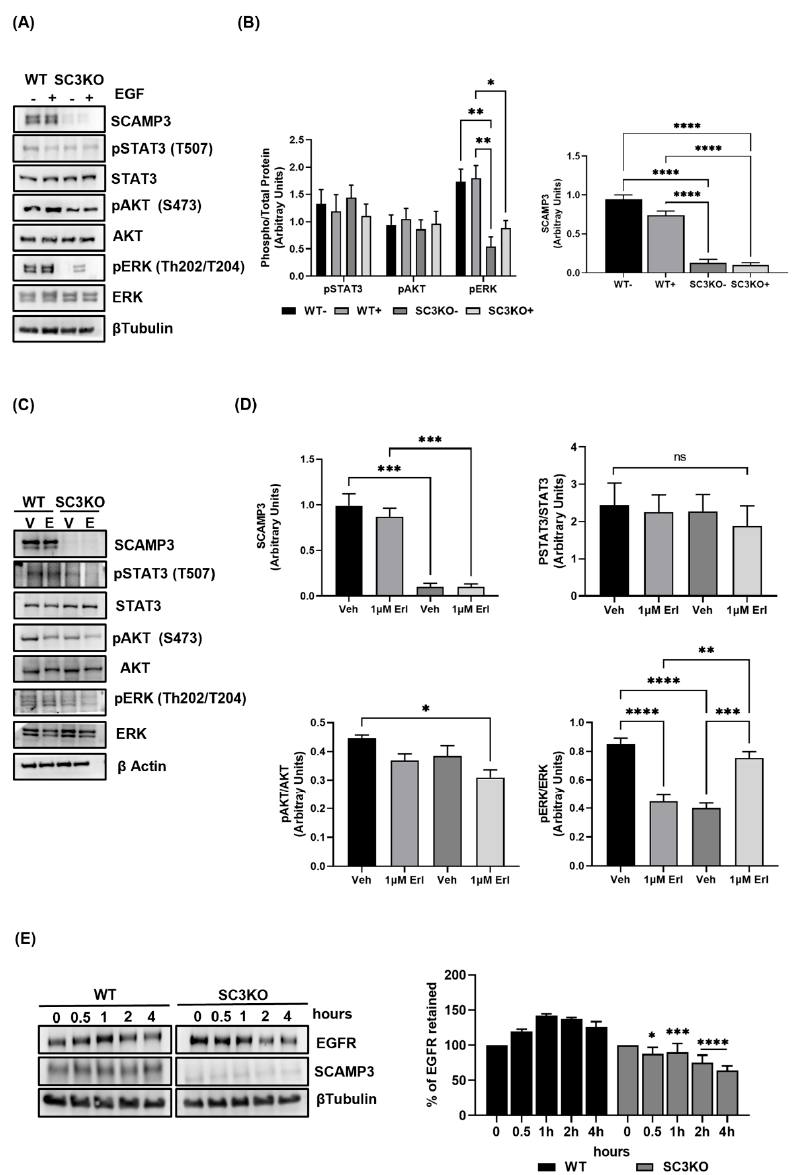
Figure 6. SCAMP3 regulates EGFR signaling by degradation of the receptor. ( A , B ) Immunoblots and densitometry quantification of SUM-149 WT or SC3KO cells after stimulation with 10 ng/mL EGF for 30 min. Lysates were probed using the indicated antibodies. Two-way ANOVA; * p ≤ 0.05, ** p < 0.01, **** p < 0.0001. ( C , D ) Immunoblots and densitometry quantification analyses of SUM-149 WT or SC3KO lysates after cells treated with 1 µ M erlotinib for 72 h. One-way ANOVA; * p ≤ 0.05, ** p < 0.01, *** p < 0.001, **** p < 0.0001, ns = not significant. ( E ) Serum starved WT and SC3KO SUM-149 cells were treated with 100 µ M cycloheximide for 1 h before stimulation with 10 ng/mL of EGF. Lysates were obtained after each time point shown and immunoblotted using SCAMP3 and EGFR antibodies. After densitometry analysis, the EGFR intensities data were normalized to β -tubulin and correlated to 0 h. The plotted data represent the residual EGFR. t -test, * p ≤ 0.05, *** p < 0.001 and **** p < 0.0001. Data are represented as mean ± SEM. The experiments were carried out at least three